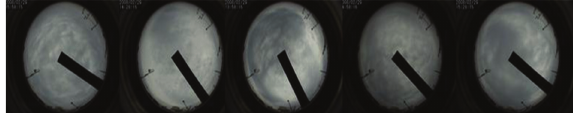
Figure 1: Whole sky images for April 4, 2008, over Cape Hedo, Japan.